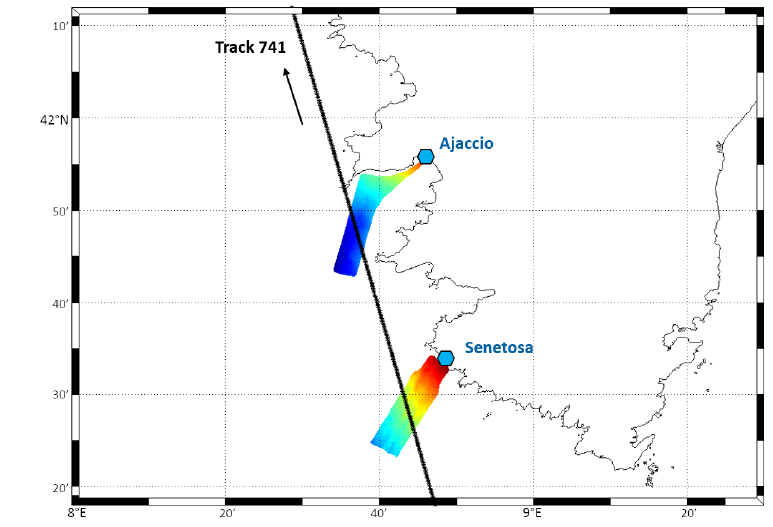
Figure 24. Configuration for absolute calibration off Corsica. The regions in colours show the two high-resolution mean sea surfaces that were specifically measured by Bonnefond et al. [41] to link the calibration sites to the altimetry